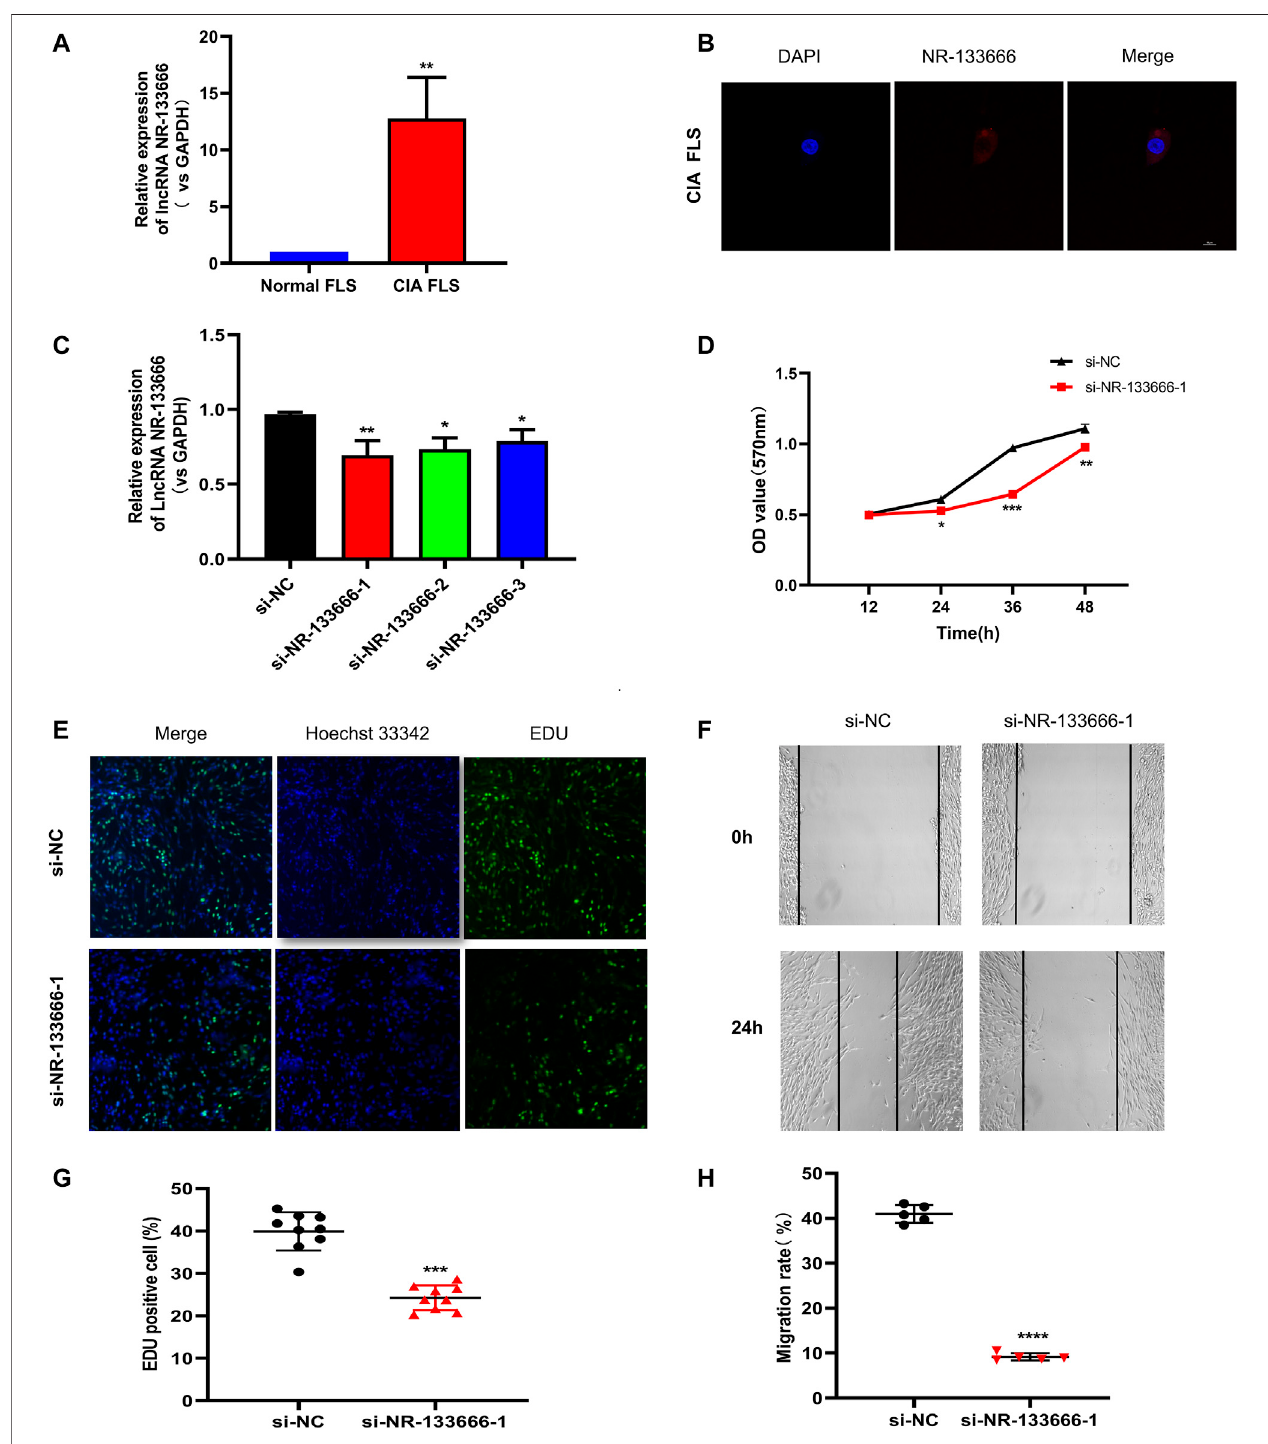
FIGURE3| lncRNANR-133666ishighlyexpressedinthecytoplasmofCIAFLSandpromotesCIAFLSproliferationandmigration. (A) qRT-PCRshowedthatNR- 133666 was increased in CIA FLS. (B) RNA-FISH localization of NR-133666 in CIA FLS. (C) qRT-PCR showed that NR-133666 was reduced in si-NR-133666- transfected macrophages, among them si-NR-133666-1 was the most obvious. (D) MTT showed that the proliferation of si-NR-133666-1 transfected CIA FLS was reduced. (E,F) EdUassayshowingCIAFLS proliferationdecreased aftertransfection withsi-NR-133666-1 (100×). (G,H) Themigratory abilityofCIAFLS cellswas weakened after transfection with si-NR-133666-1, measured by wound healing assay (100×). Compared with controls, * p < 0.05, ** p < 0.01, *** p < 0.001, **** p < 0.0001.